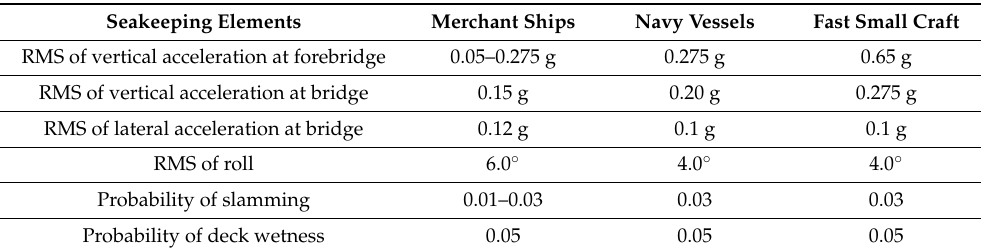
Table 5. Seakeeping criteria proposed by the Nordic Cooperative Research Program.